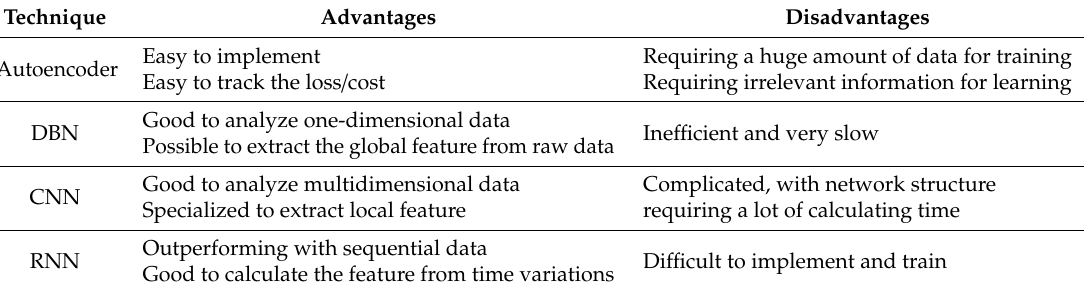
Table 1. Comparison of deep learning